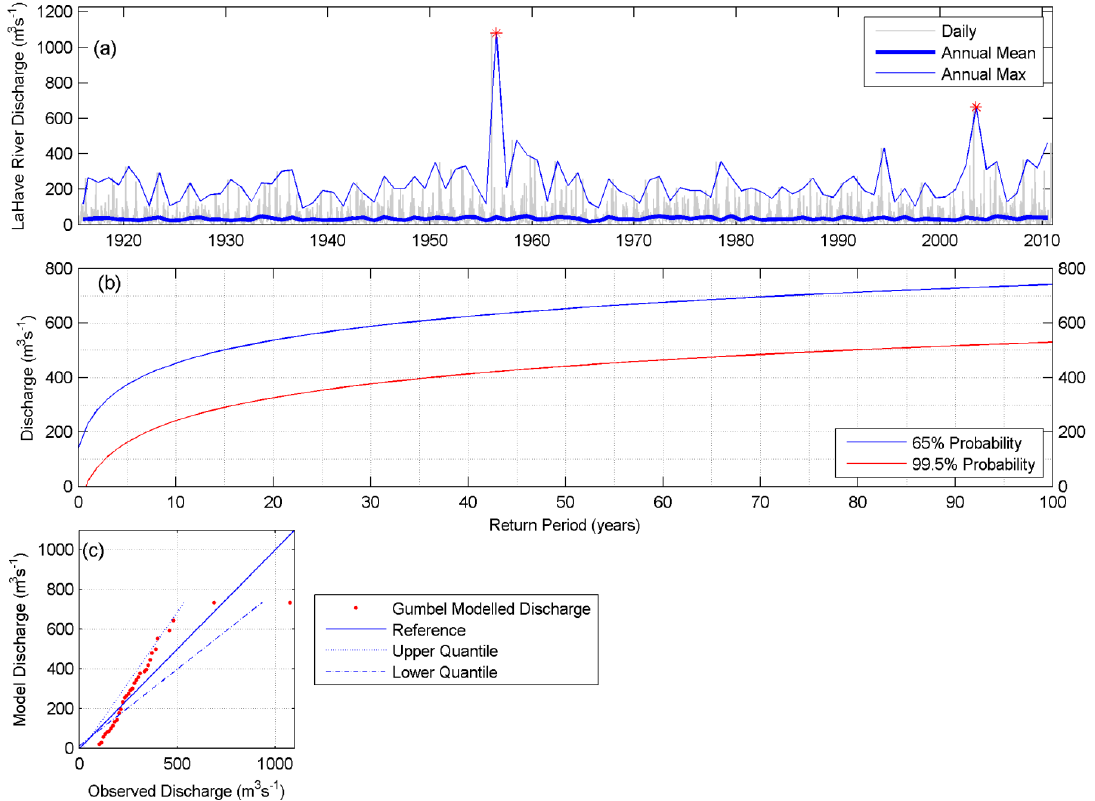
Figure 5. ( a ) Time series of daily, annual mean and annual maximum discharge (m 3 /s) of the LaHave River from the Environment Canada gauge. Red asterisks represent the flooding in 1956 and 2003; ( b ) Design Level graph for LaHave River discharge at 99.5% and 65% probability; ( c ) the Gumbel distribution used to model annual maximum LaHave